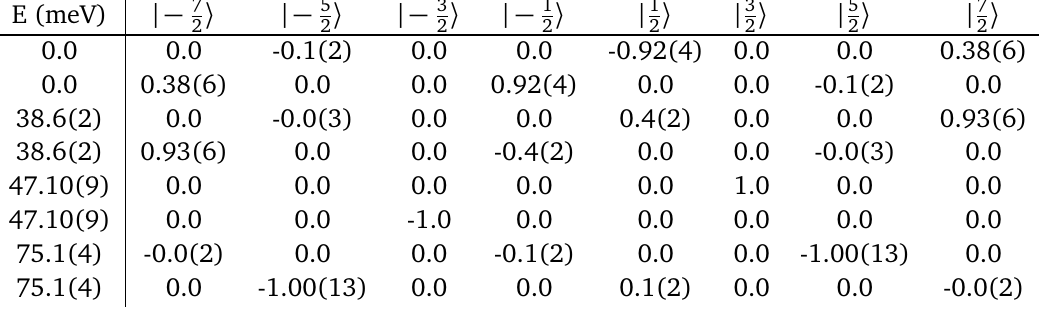
CEF Hamiltonian with uncer-